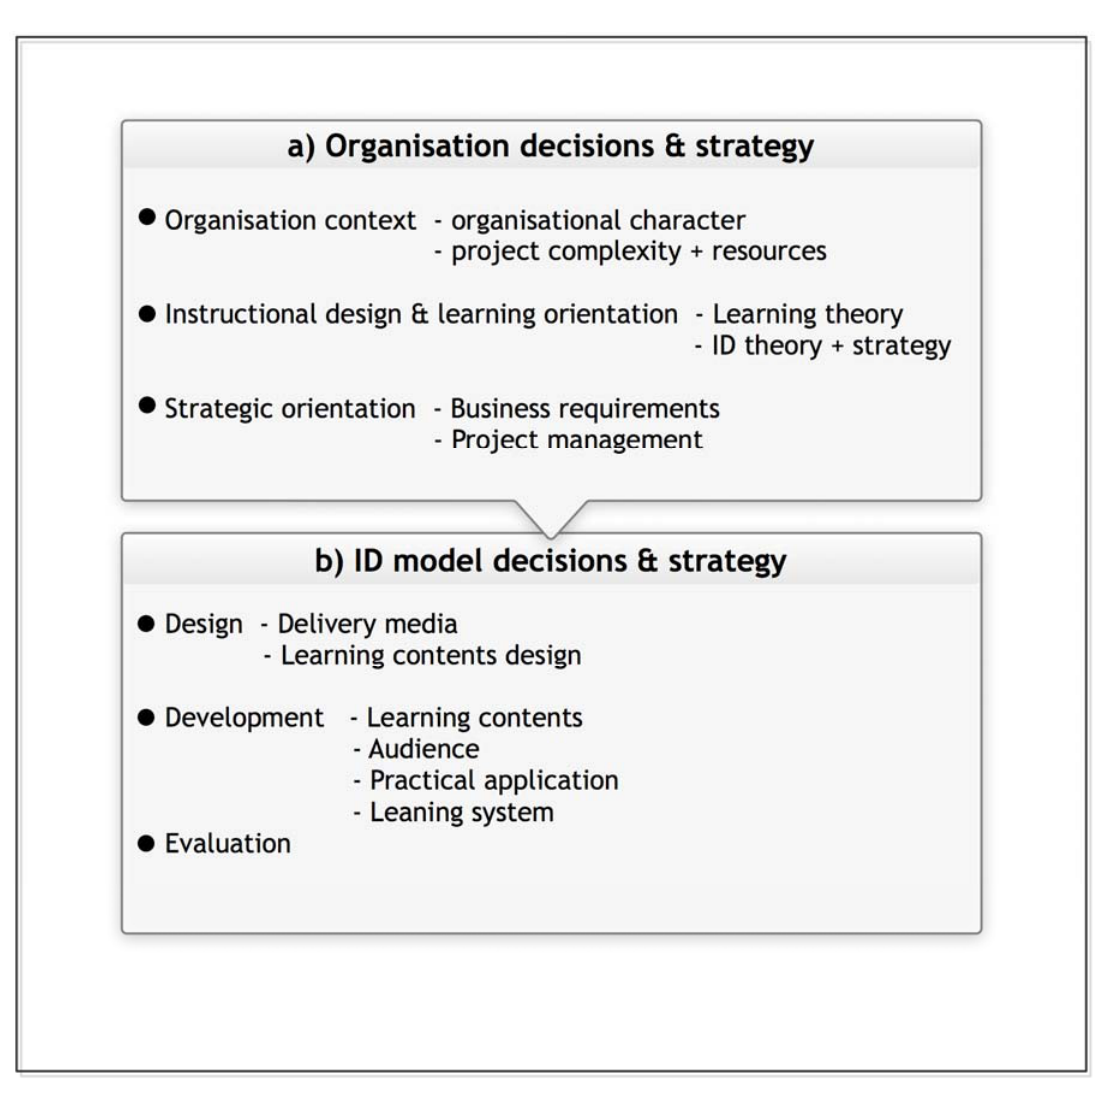
Figure 2: Diagrammatic view of the strategic ID